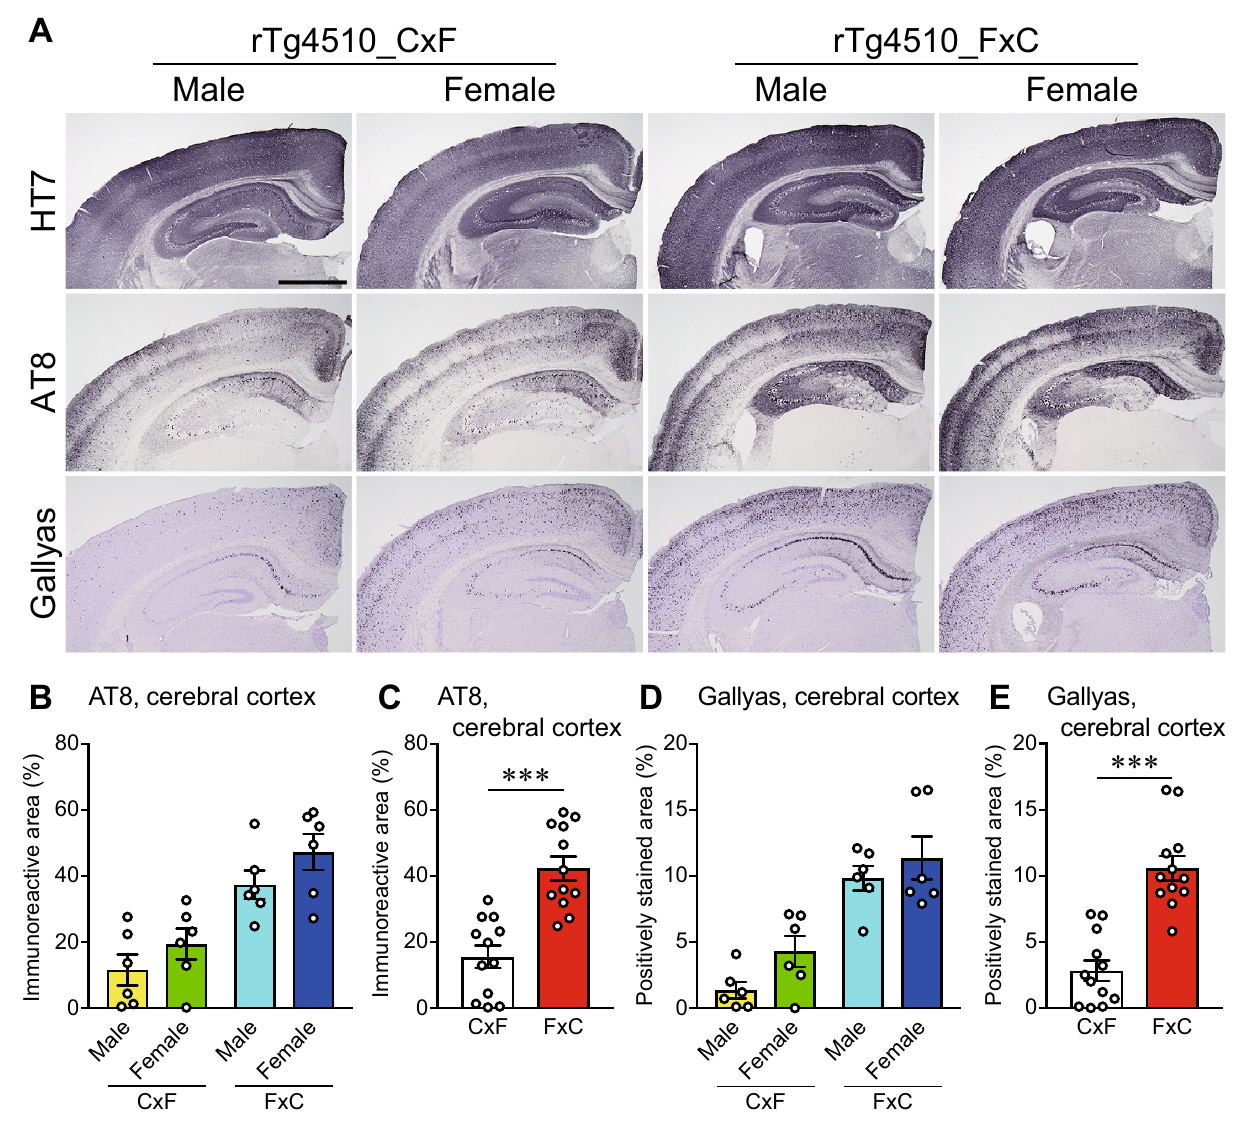
Figure 1. Abnormally phosphorylated tau and Gallyas-positive structures in the brains of rTg4510 mice at 6 months of age. ( A ) Representative photographs of the immunohistochemical results for human tau (clone HT7), phosphorylated tau (clone AT8), and Gallyas silver staining. Scale bar: 1 mm. ( B – E ) Quantitative analysis of the AT8-immunoreactive area and Gallyas-positive stained area. Two-way ANOVA (genetic background × sex) revealed a main effect of the genetic background, but no effect of sex, in the AT8- immunoreactive area ( B ) and Gallyas-positive stained area ( D ) of the cerebral cortex (Supplementary Table S1). The Mann–Whitney U test revealed significantly higher levels of AT8-immunoreactivity ( C ) and Gallyas- positive staining ( E ) in samples obtained from the rTg4510_FxC mice, as compared with the rTg4510_CxF mice. The rTg4510_CxF and rTg4510_FxC groups contained six males and six females each ( n = 12/group). Data are presented as the mean ± SEM. *** p < 0.001 (Mann–Whitney U